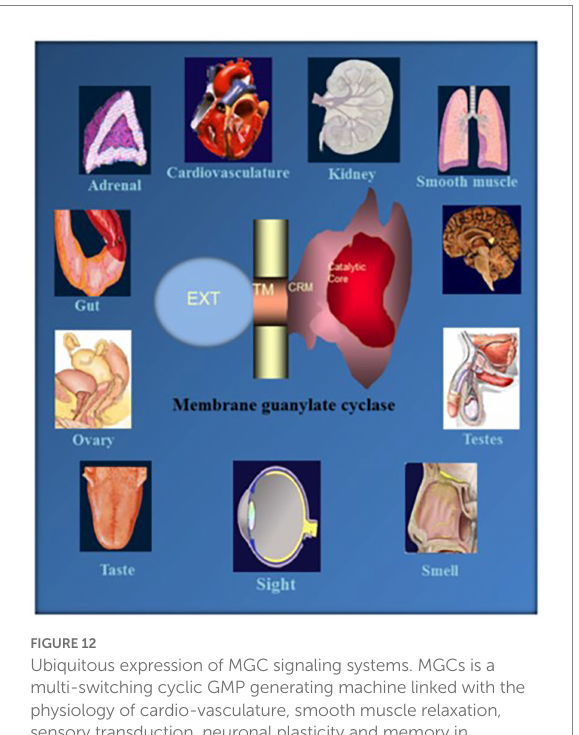
FIGURE 12 Ubiquitous expression of MGC signaling systems. MGCs is a multi-switching cyclic GMP generating machine linked with the physiology of cardio-vasculature, smooth muscle relaxation, sensory transduction, neuronal plasticity and memory in mammalian neurosensory, endocrine and peripheral tissues. (Reproduced from Sharma et al.,